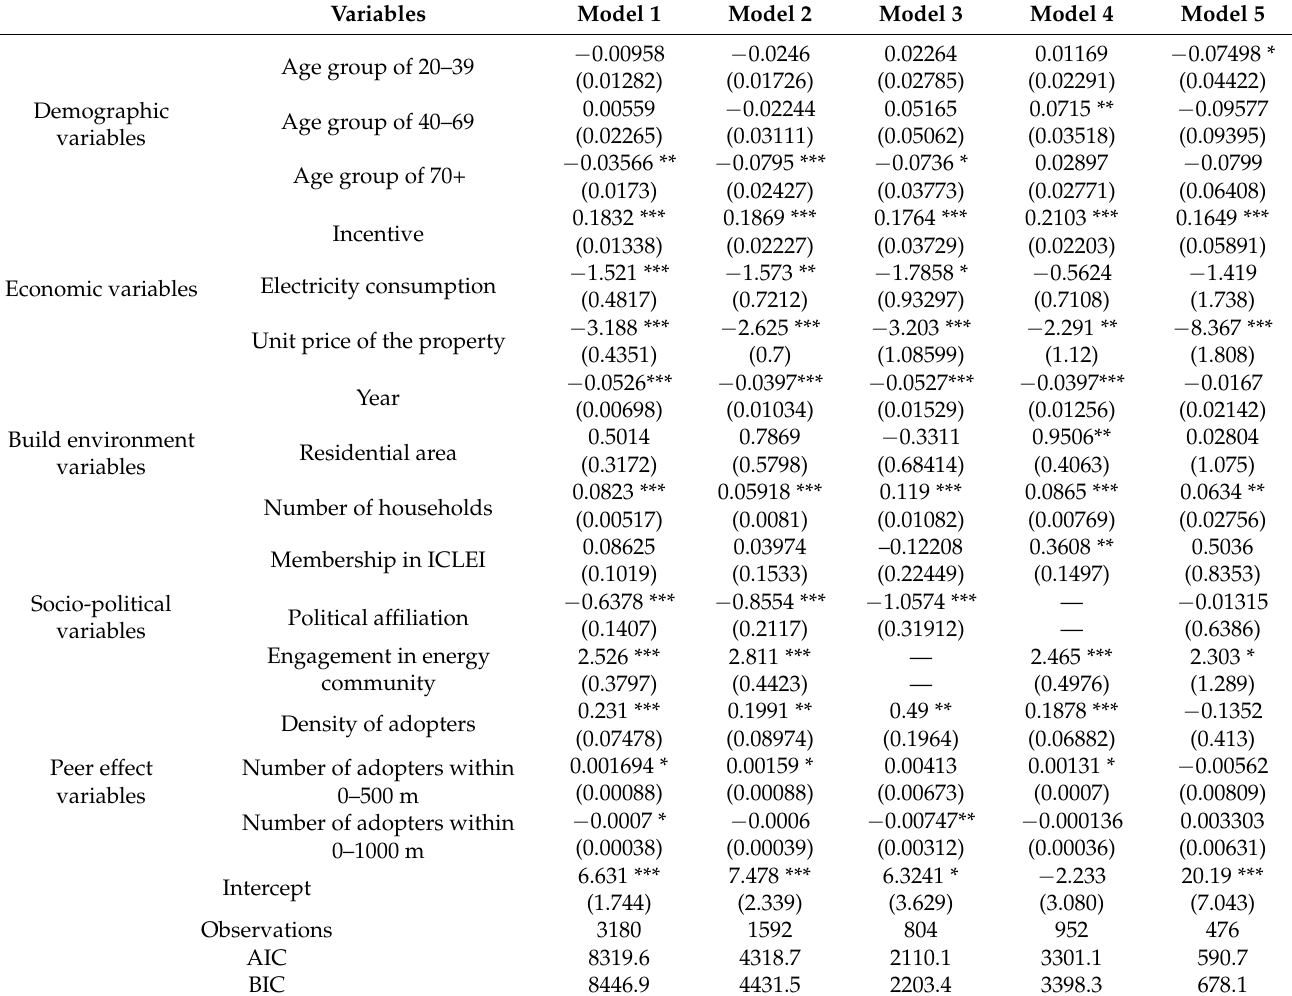
Table 3. Zero-inflated negative binomial regression on the adoption of mini-solar